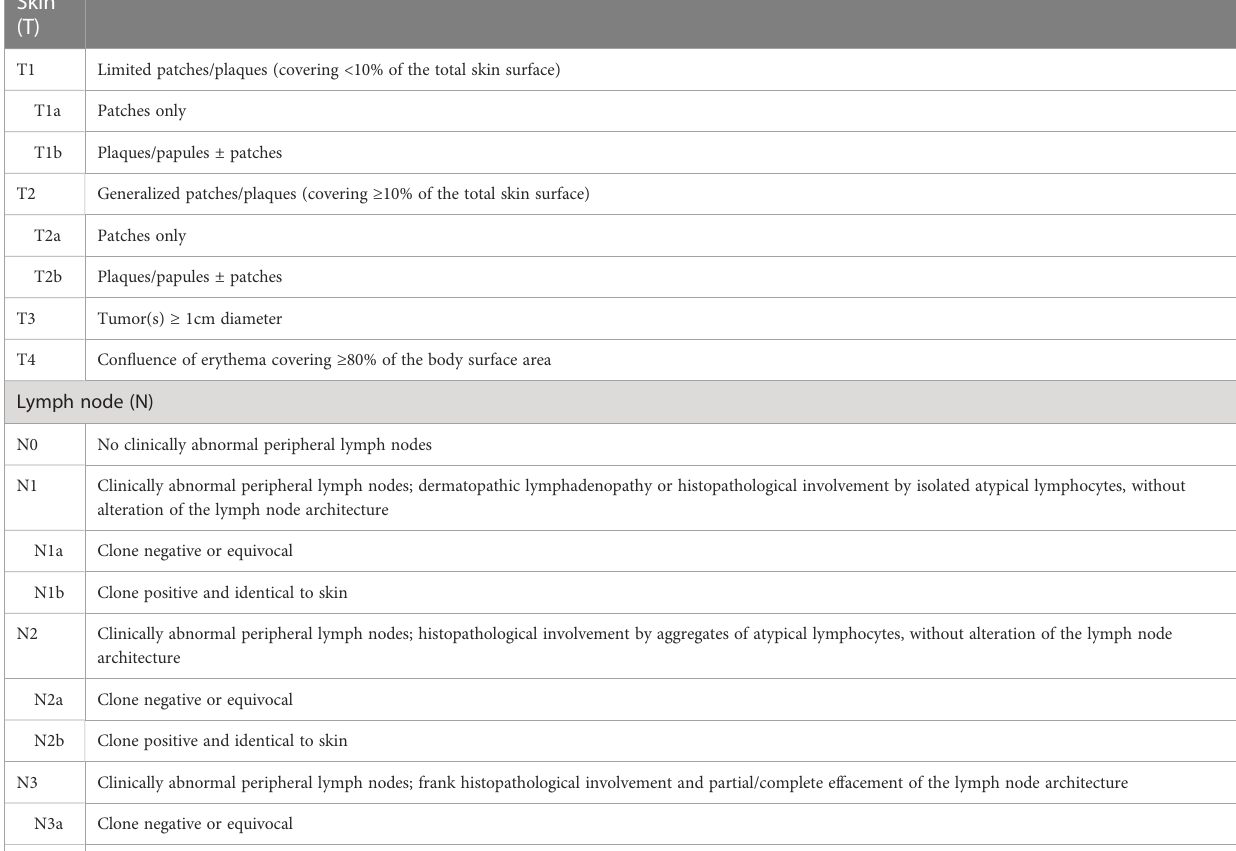
TABLE 2 Revised TMNB classi fi cation for MF and